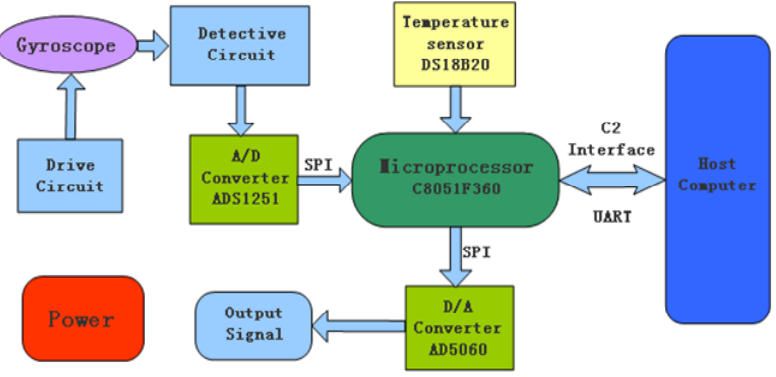
Figure 8. The hardware setup of the temperature compensation